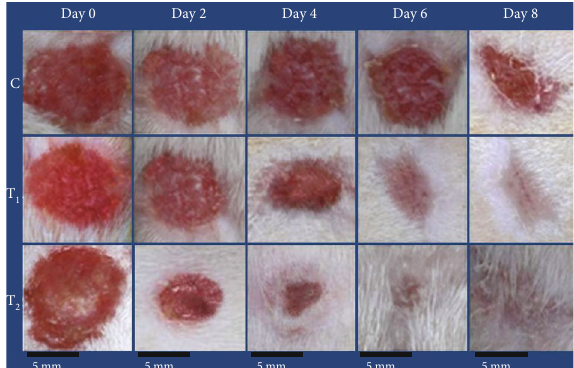
Figure 5: Consequence of rats ’ wounded skin treatment with nanochitosan/henna extract composite (T1) and nanochitosan/ henna extract/ fi sh collagen composite (T2) on the healing rate of wounds throughout 8 days, compared to untreated (C)